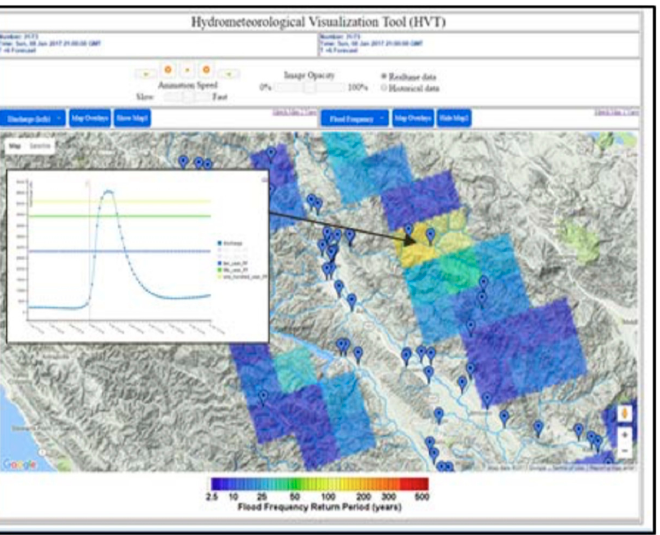
Figure 7. Example of HVT display showing a time series of streamflow (hydrograph) at a user selected location. The hydrograph indicates flood frequency levels associated with the grid ele- ment corresponding to the user-specified location.